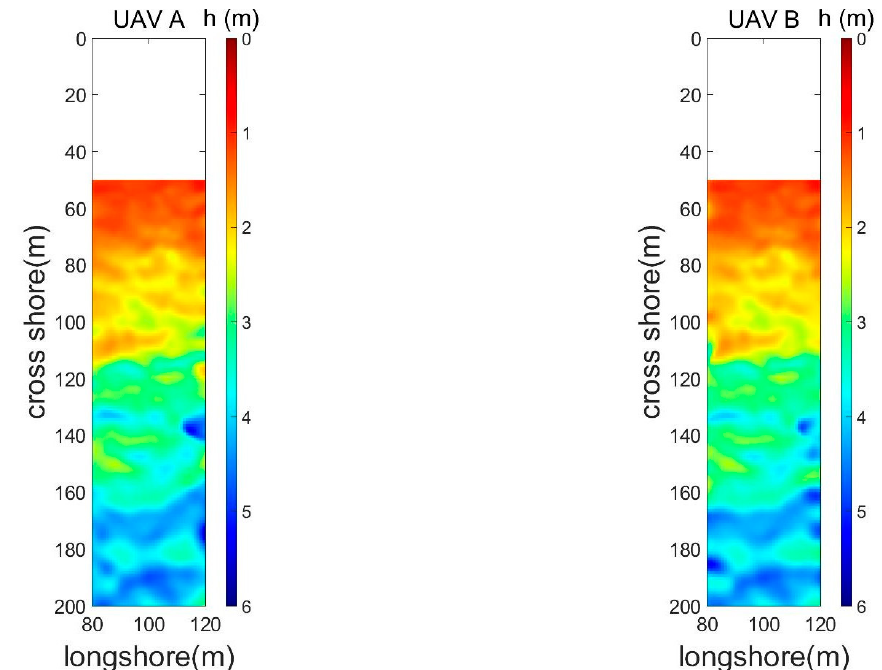
Figure 23. Bathymetry results of the common field captured by the two UAVs.